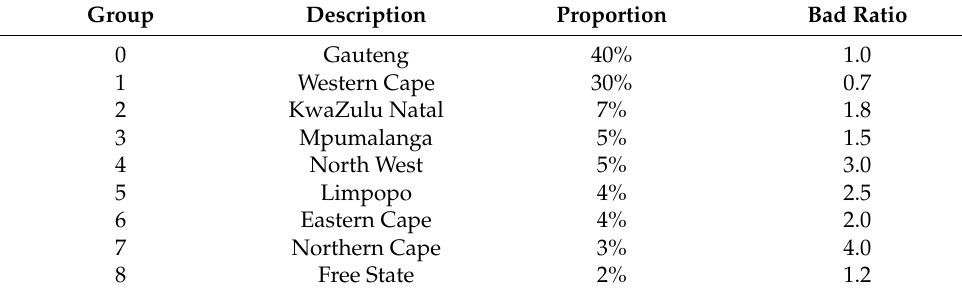
Table A2. Province of